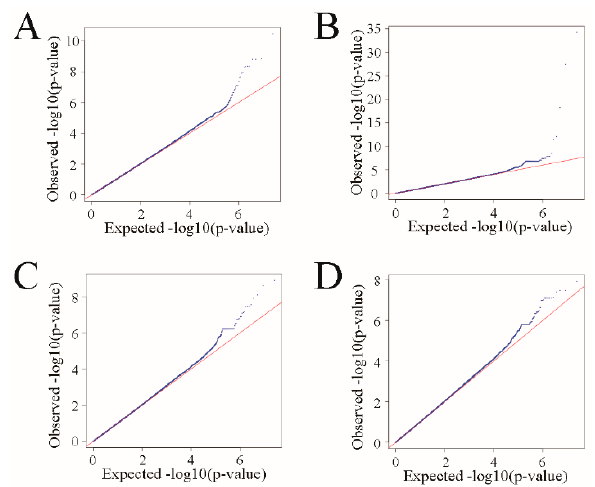
Figure 2. Quantile-quantile plots of body weight traits using mixed linear model approach. Blue dots represent the − log10 ( p -value) of the entire study and the red line represents the expected values under the null hypothesis of no association. ( A ) birth weight; ( B ) weaning weight; ( C ) yearling weight; ( D ) adult weight. Table 1. Genome-wide association studies (GWAS)-identified significant single-nucleotide polymorphisms (SNPs), associated traits, and nearest candidate genes.